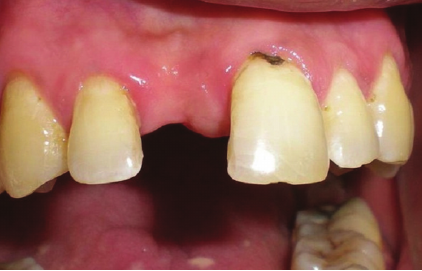
Figure 1: Missing maxillary right central incisor prior to